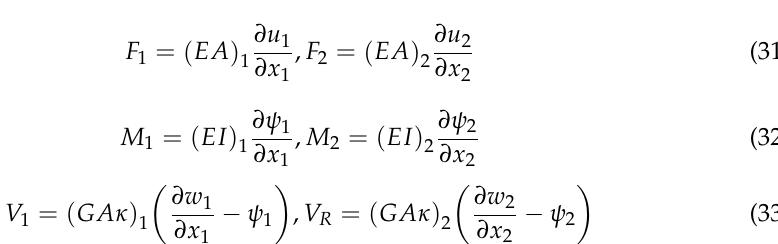
Figure 3. Free body diagram of an L-joint. (Reprinted with permission from Ref. [31]. 2012, ASME Publishing.).